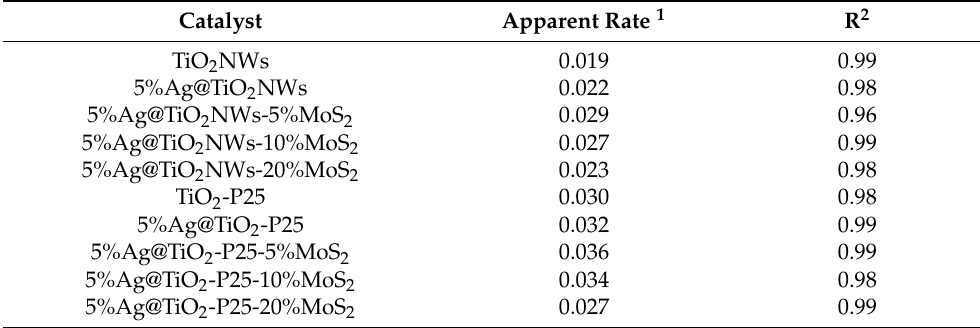
Table 3. The pseudo-first-order kinetics constants for the photodegradation of ciprofloxacin using TiO 2 NW- and TiO 2 -P25-based catalysts. Catalyst Apparent Rate 1 R 2